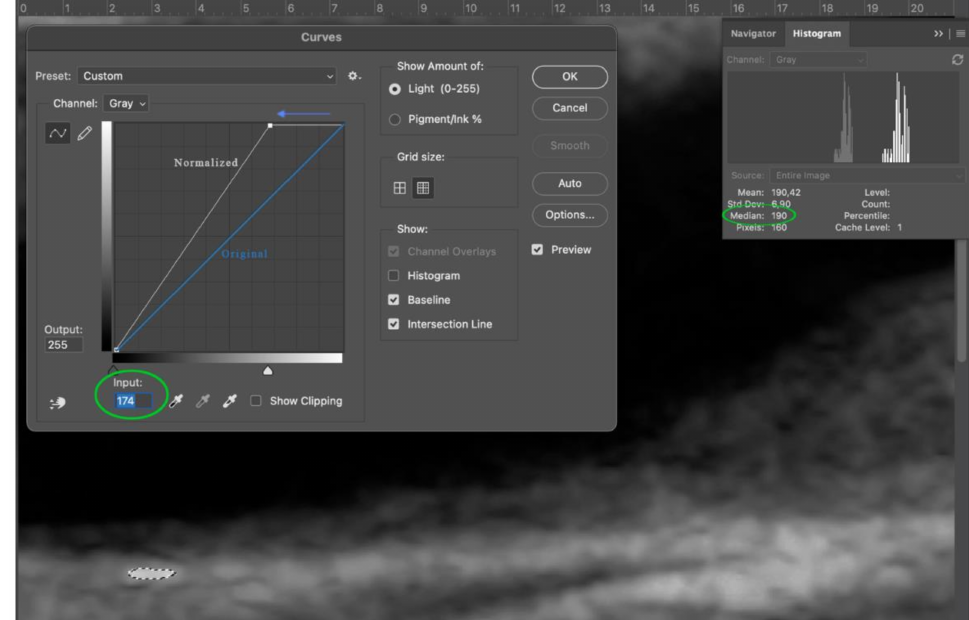
Figure 4. Step 3: move the apex of the straight line (blue) to the left in order to reach a median value of 190 on the histogram (green circle). During normalization only input value changes. Fourth step: the entire image was normalized via curves with respect to the values pre- viously obtained from normalization of adventitia. The plaque margins were outlined with the lasso tool and the median value showed on histogram was the GSM value (Figure 5).